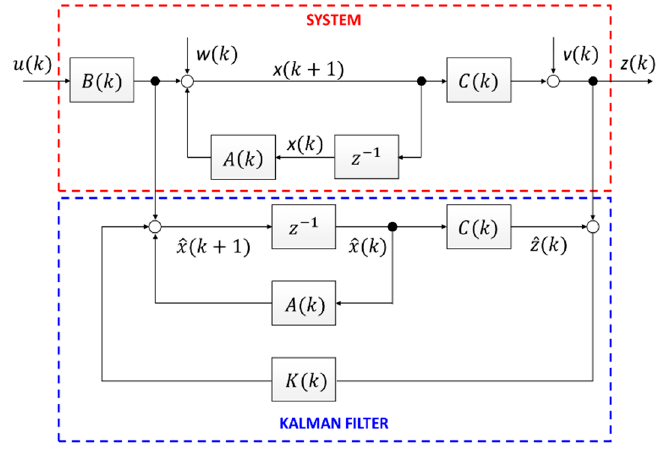
Figure 3. Kalman filter (KF) structure.